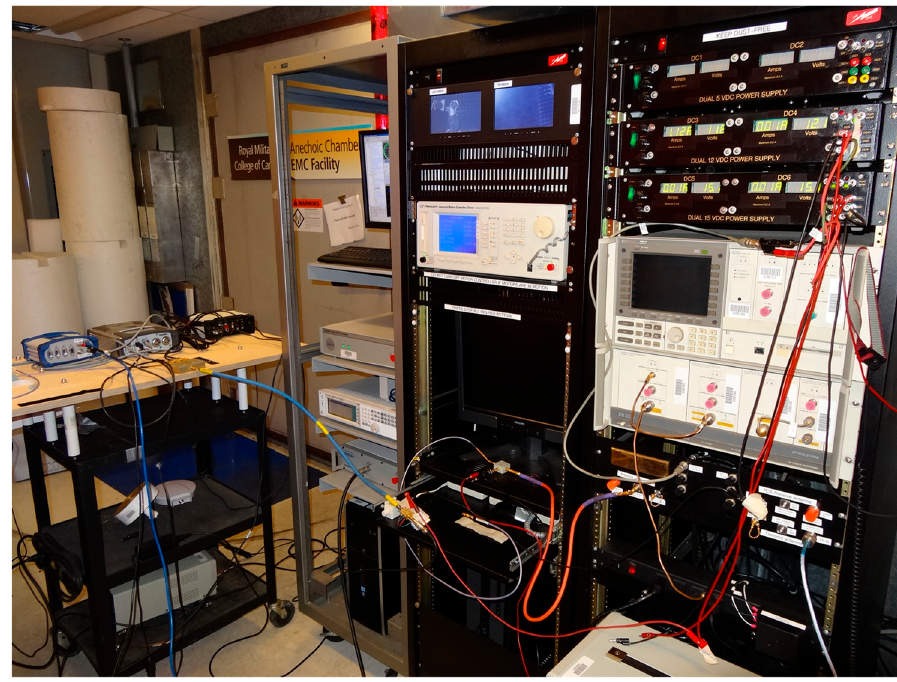
Figure 10. A photo of the Equipment (Outside of the Room).